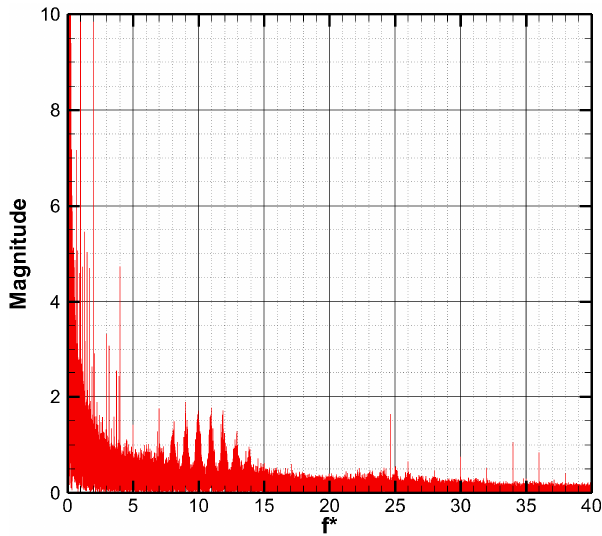
. m purge is 0.28%). Figure 5. FFT of pressure signals from Transducer 2, Case 1 ( 𝒎(cid:4662) 𝒑𝒖𝒓𝒈𝒆 is 0.28%).